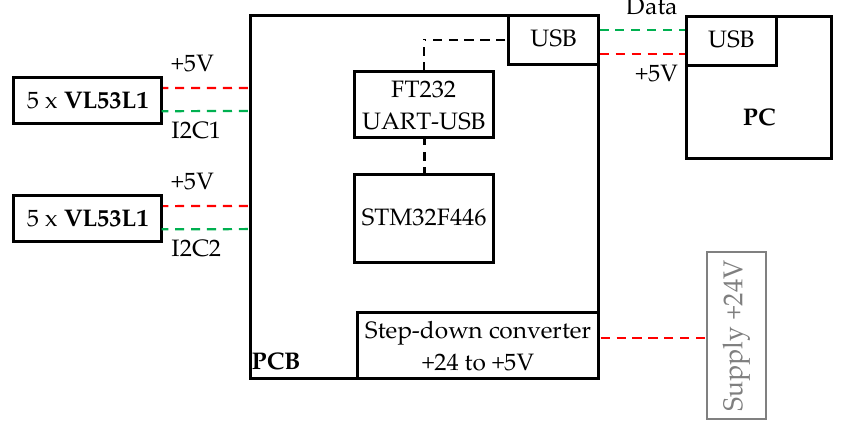
13 of 25 Figure 6. Visualization of cones and field of view for every VL53L1 time-of-flight sensor. In order to collect distances from sensors and preliminary data analysis, a PCB with microcontroller STM32F446 was designed and made. The board communicates with the